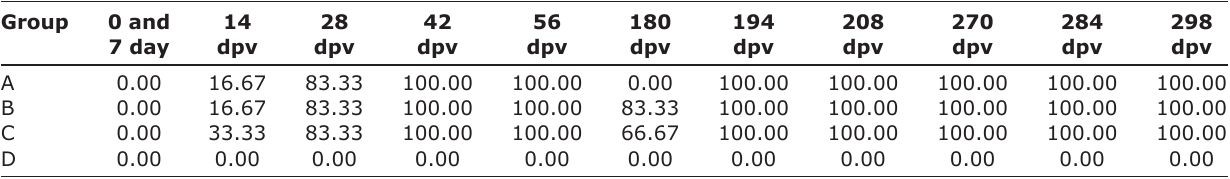
1.50 (1:32) against CSFV in different groups at 10